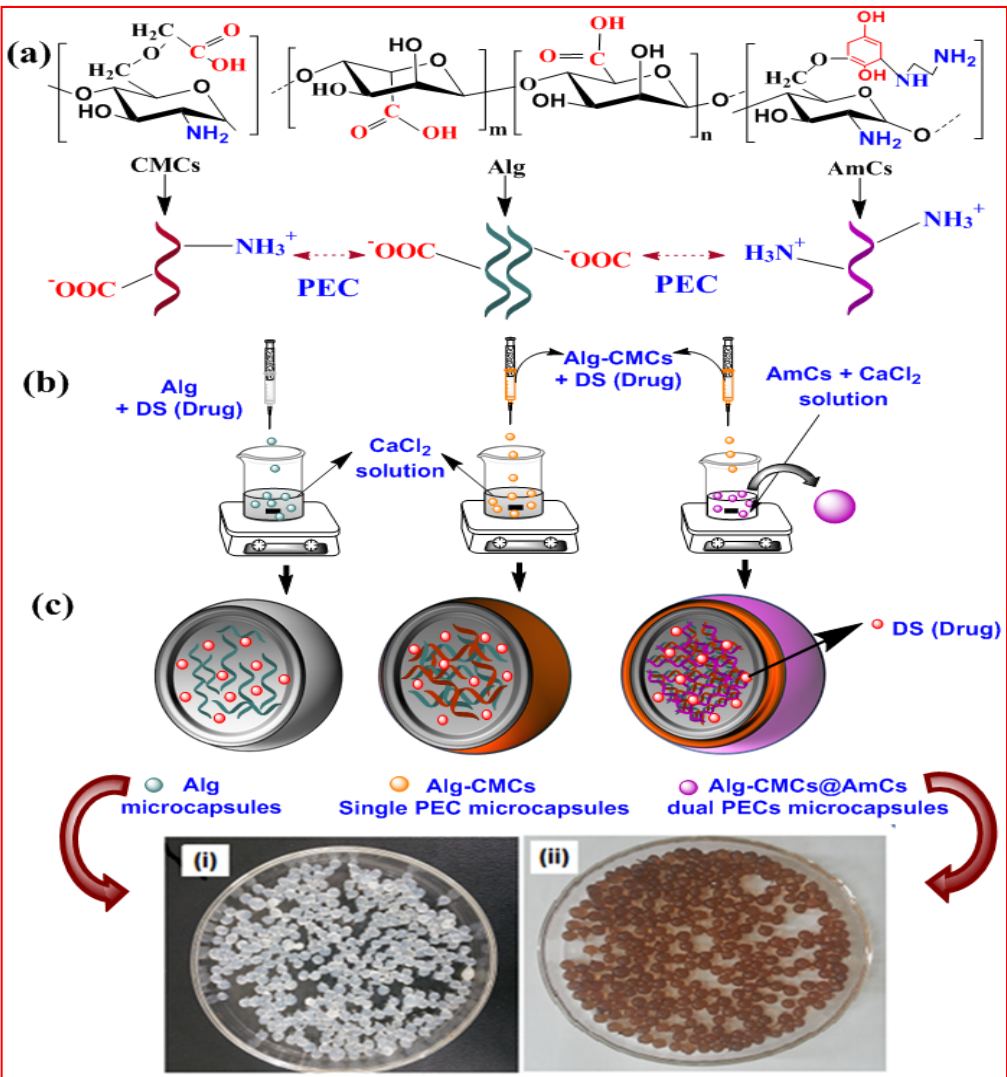
Figure 1. (a) proposed scheme for the polyelectrolyte complex formation between alginate (Alg), carboxymethyl chitosan (CMCs), and aminated chitosan (AmCs), (b) a schematic diagram for the formulation of diclofenac sodium (DS)-loaded Alg, Alg-CMCs, and Alg-CMCs@AmCs dual polyelectrolyte complexes (PECs) microcapsules and (c) digital laboratory image for freshly ( i ) Alg and ( ii ) Alg-CMCs@AmCs wet microcapsules.